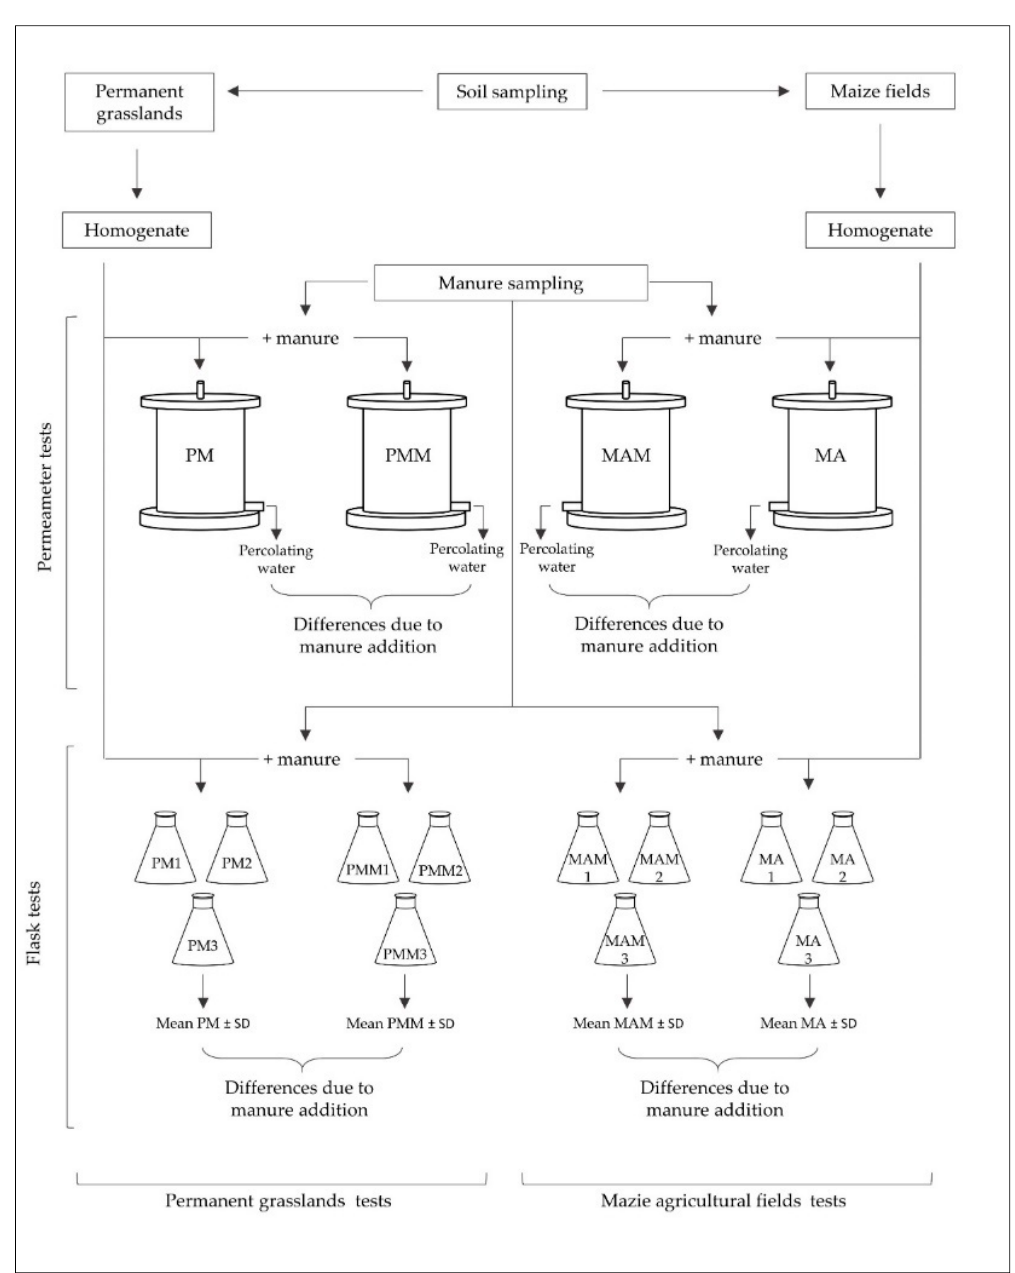
Figure 3. Laboratory tests flow chart.